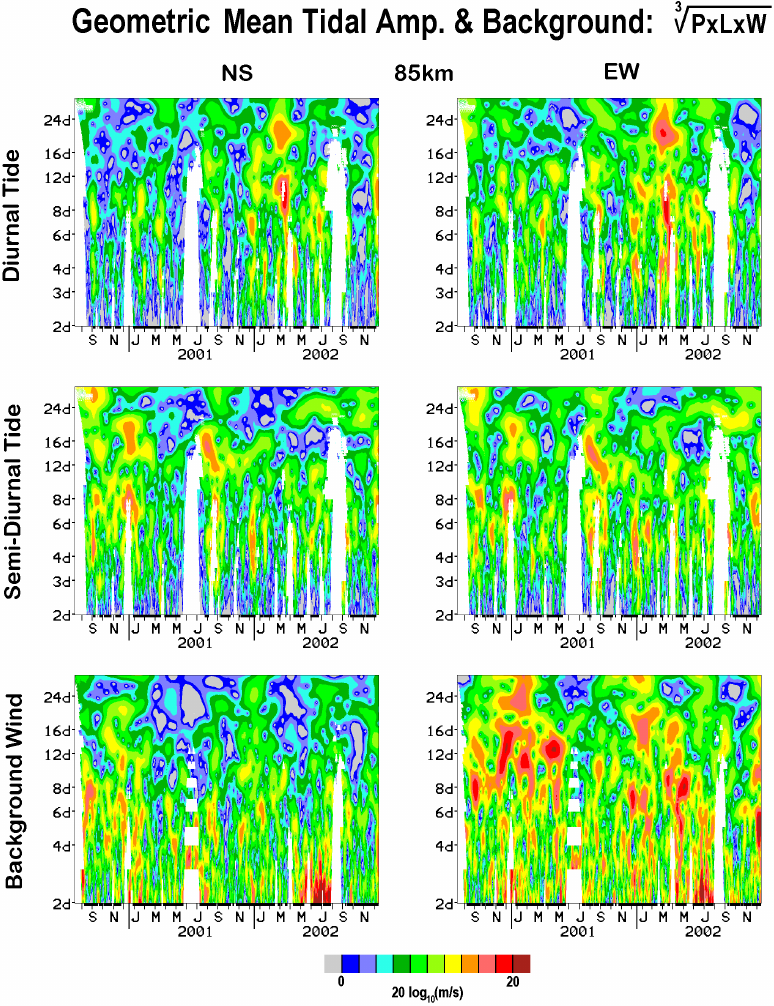
Fig. 5. Wavelet spectral plots for the 85km daily winds, 12-h (semidiurnal) and 24-h (diurnal) tidal amplitudes (zonal EW, meridional NS). These plots are geometric means of the individual wavelets for the three 40–45 ◦ N MF radars (London, Platteville, and Wakkanai) of the CUJO network. A gap is shown if an amplitude value is unavailable for one or more